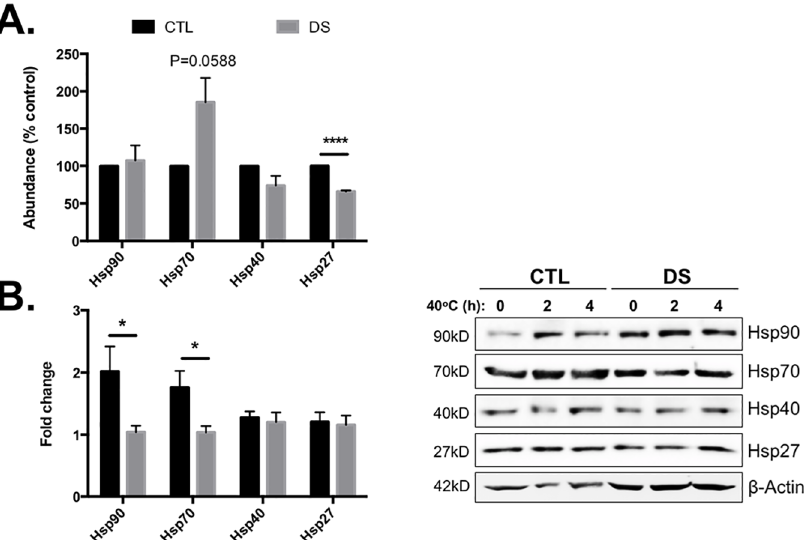
Fig 7. Impaired heat shock response in DS fibroblasts. Basal levels of most heat shock proteins (Hsp) investigatedwere not significantly different controls; however, Hsp27 was significantly decreased in DS cells (A). Stimulation of these cells for 2h with 40˚C heat stress did not result in a significantincrease in Hsp90 or 70 (B). These results indicatean abnormalHSF-1 responsein DS fibroblasts. Graphs represent results of Western blotting experiments that were conducted in triplicate. Data is representedas the mean ± SEM ( * P < 0.05, **** P < 0.0001).